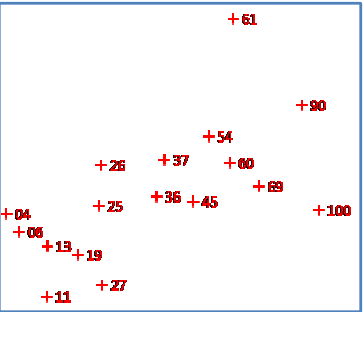
Figure 1. Configuration of GCPs